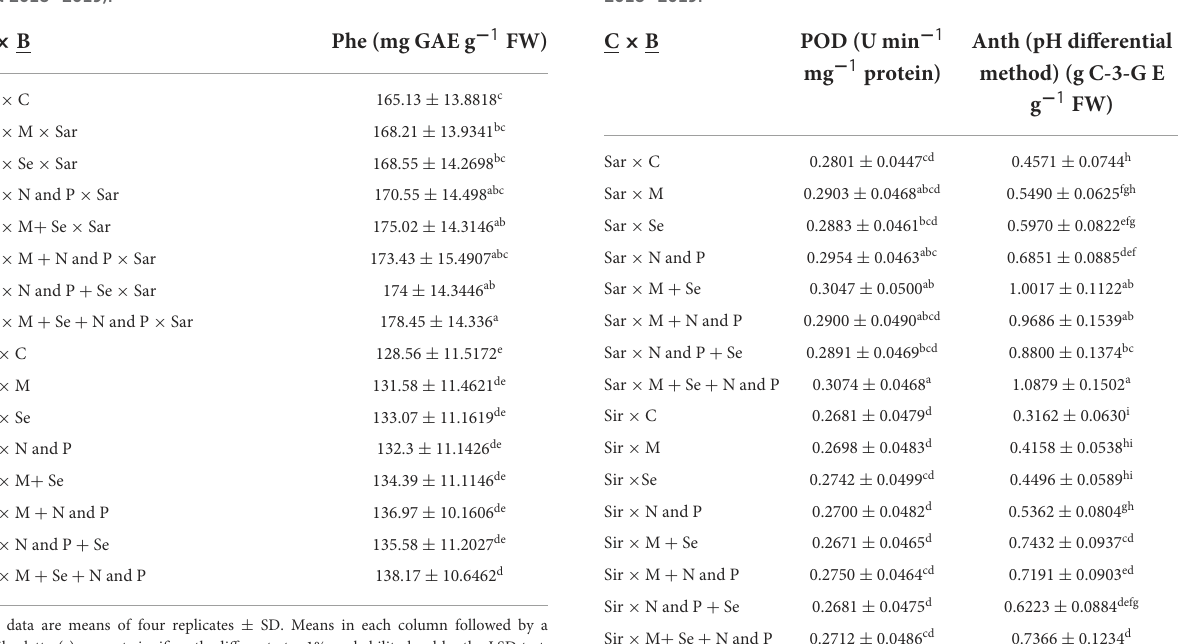
TABLE 9 Mean comparisons of the dual interactions of cultivar and bio-fertilizers on Phenol content in 2 years of experiment (2017–2018 and 2018–2019).